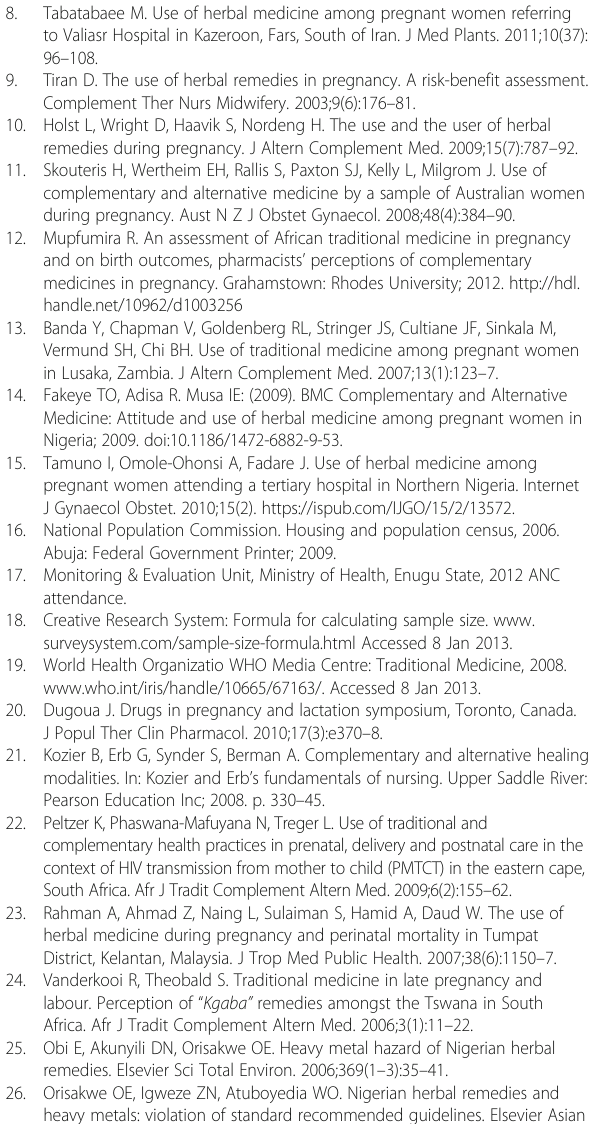
Tabatabaee M. Use of herbal medicine among pregnant women referring to Valiasr Hospital in Kazeroon, Fars, South of Iran. J Med Plants.